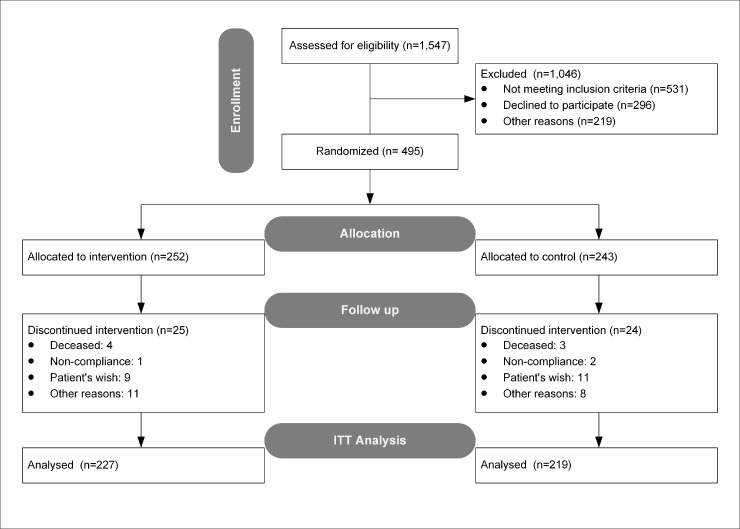
CONSORT flowchart.